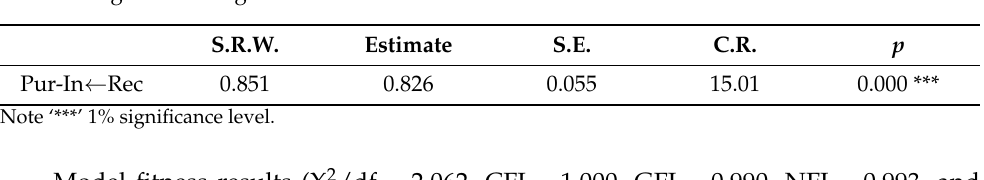
Table 5. Regression